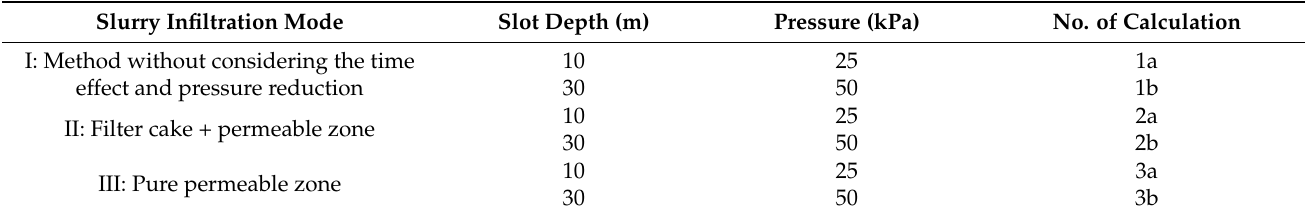
Figure 8. The local failure model of the slot at the diaphragm wall.